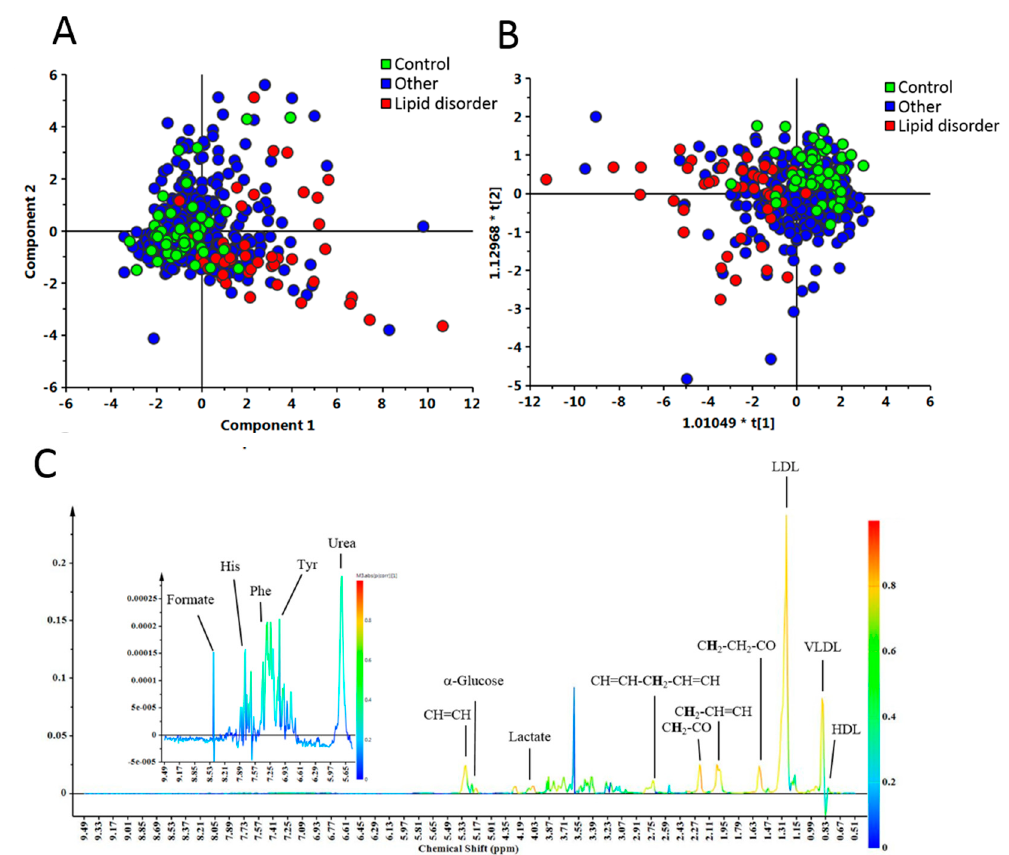
Figure 2. Metabolites were significantly different between the control and lipid disorder (LD) groups. The metabolic profile of the plasma from elderly people was analyzed with nuclear magnetic resonance (NMR) spectroscopy. ( A ) Principal component analysis (PCA) score plot showing progressive change from 47 control (green), 333 other (blue) and 43 LD (red) participants, respectively; ( B ) Orthogonal partial least squares discriminant analysis (OPLS-DA) showing metabolites can clearly discriminate the control and LD groups; ( C ) OPLS-DA coefficient loading plots derived from 1 H NMR spectra of the control and LD groups. The coefficient values above zero (upper section) represent levels of metabolites that were higher in LD group than control group. The color bar corresponds to the absolute value of the correlation loading in the discrimination model, represent metabolites that were more prevalent in the LD group.